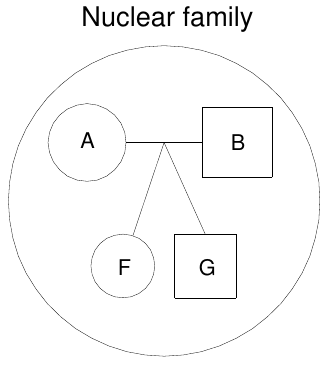
Figure 1 The nuclear family